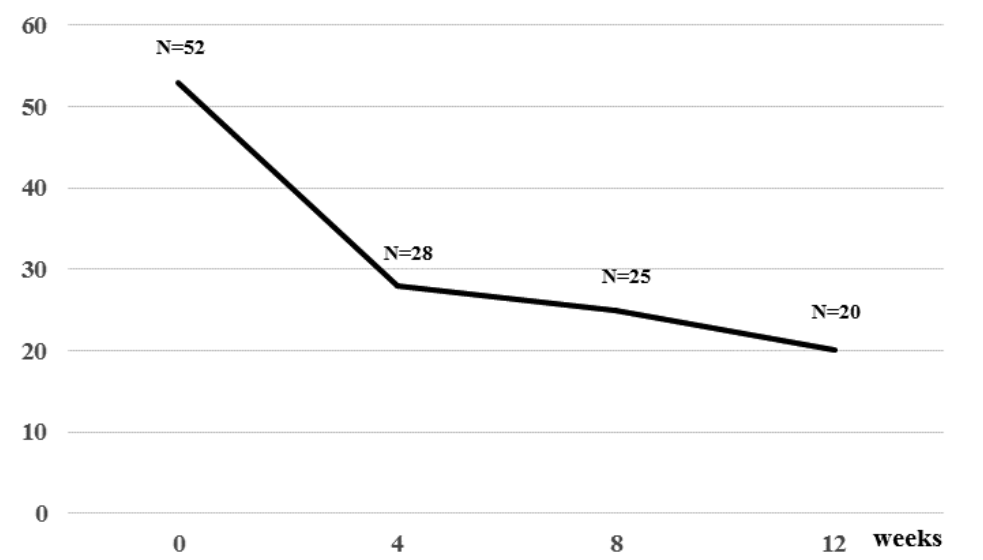
Figure 3. Timeline of participant dropout.